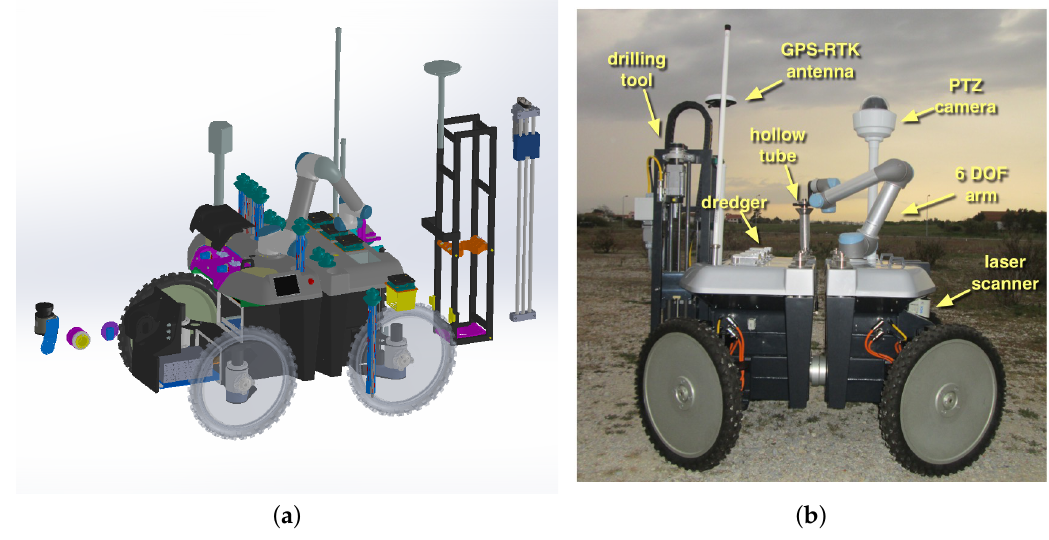
Figure 4. The Unmanned Ground Vehicle (UGV). ( a ) An exploded CAD view of the UGV; ( b ) the UGV turning around its geometric